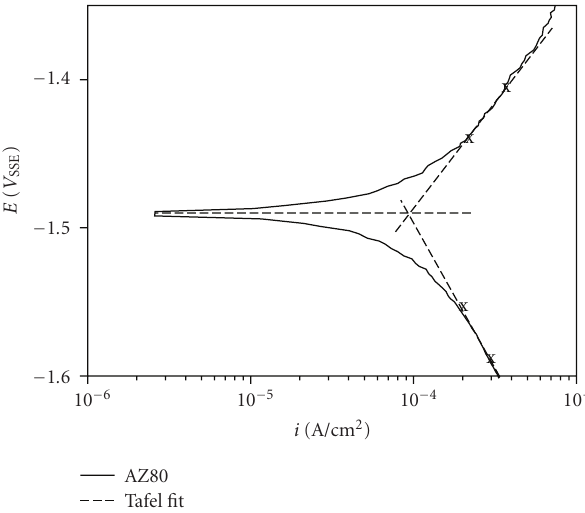
Figure 2: Example of Tafel fitting. Polarization curve of the AZ80 alloy after immersion in 3.5 wt.% NaCl for 7 days.